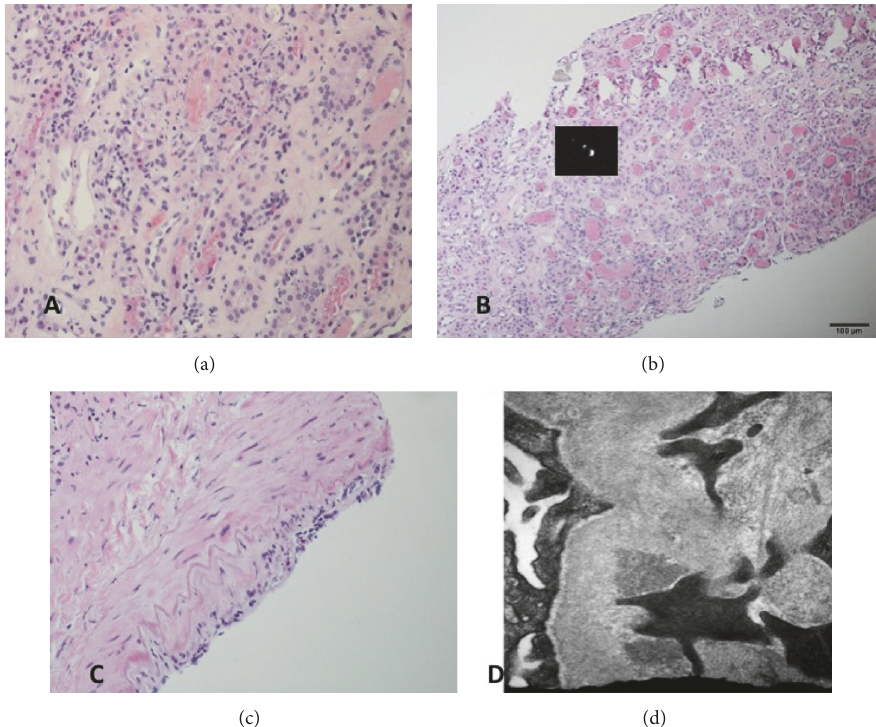
Figure 1: (a) H&E stain showing extensive acute tubular necrosis with associated peritubular capillaritis and interstitial nephritis; (b) H&E stain showing polarizable oxalate crystals in a tubule; (c) H&E stain showing active endothelialitis in one large caliber artery, (d) electron microscopy showing electron-dense deposits with immunoreactivity for IgA, in keeping with a remote IgA-dominant immune complex mediated nephropathy in the